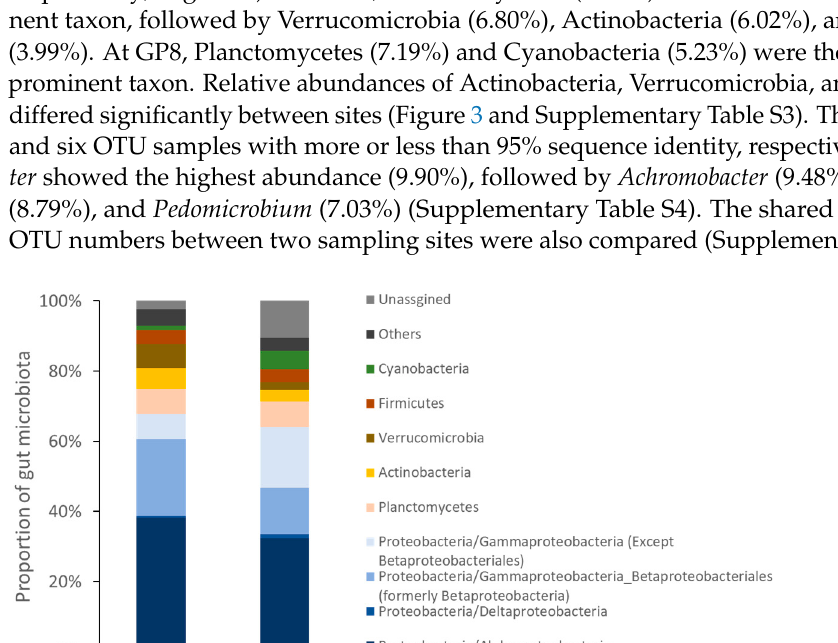
Figure 2. Shared core OTUs between sampling sites ( a ) and among samples ( b ).